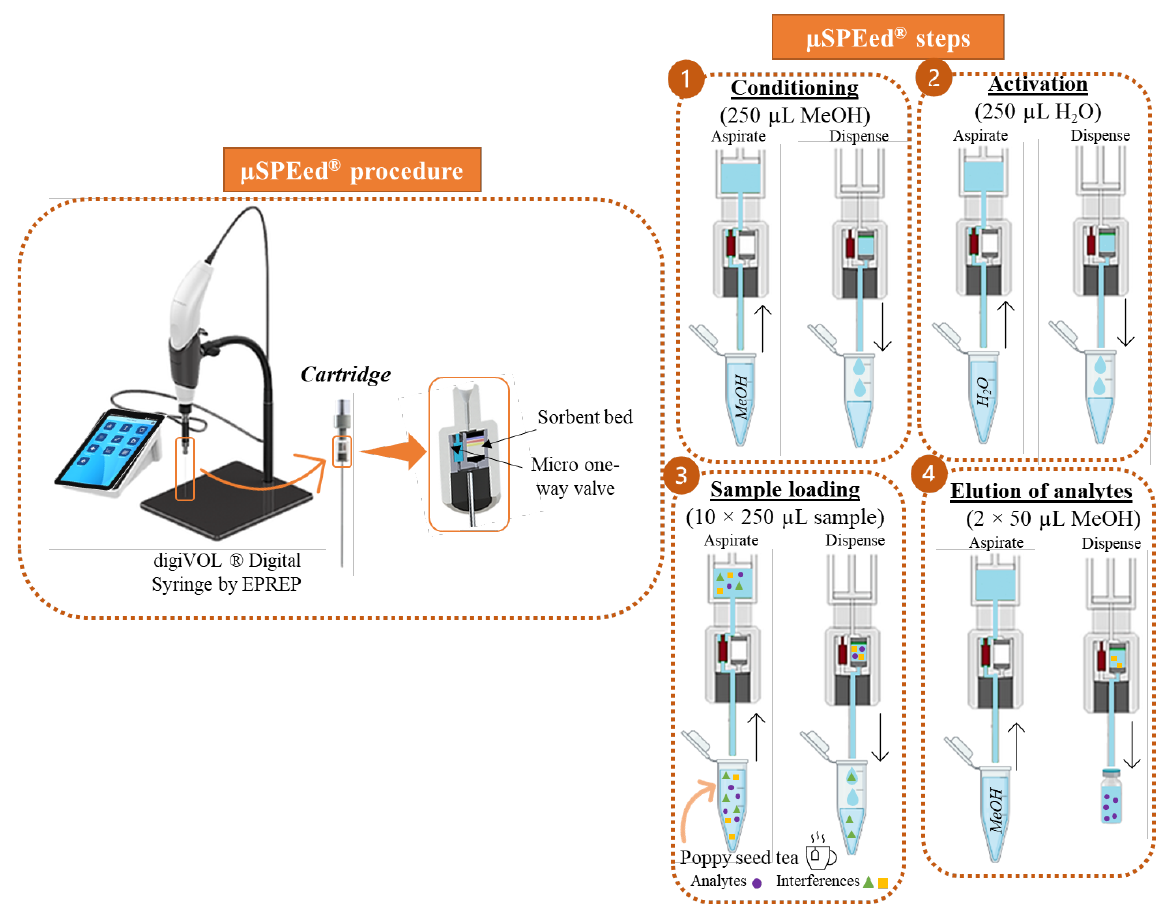
Figure 1. Graphical scheme of the optimized µ SPEed ® procedure for opium alkaloid extraction using the digiVOL ® Digital Syringe (EPREP, Mulgrave, Victoria, Australia).